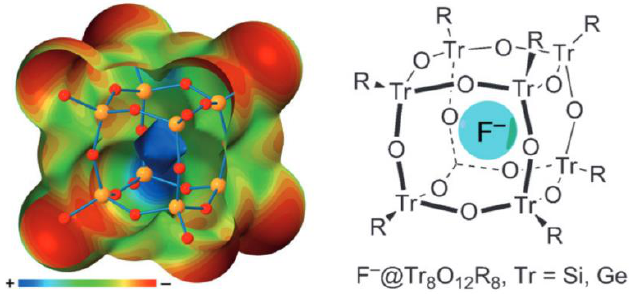
Figure 9. Left: Molecular electrostatic potential open surface of SiO 12 (OH) 8 cage. Right: A F − ion encapsulated inside a Tr 8 O 12 R 8 cage reported by Bauzá et al. [104].